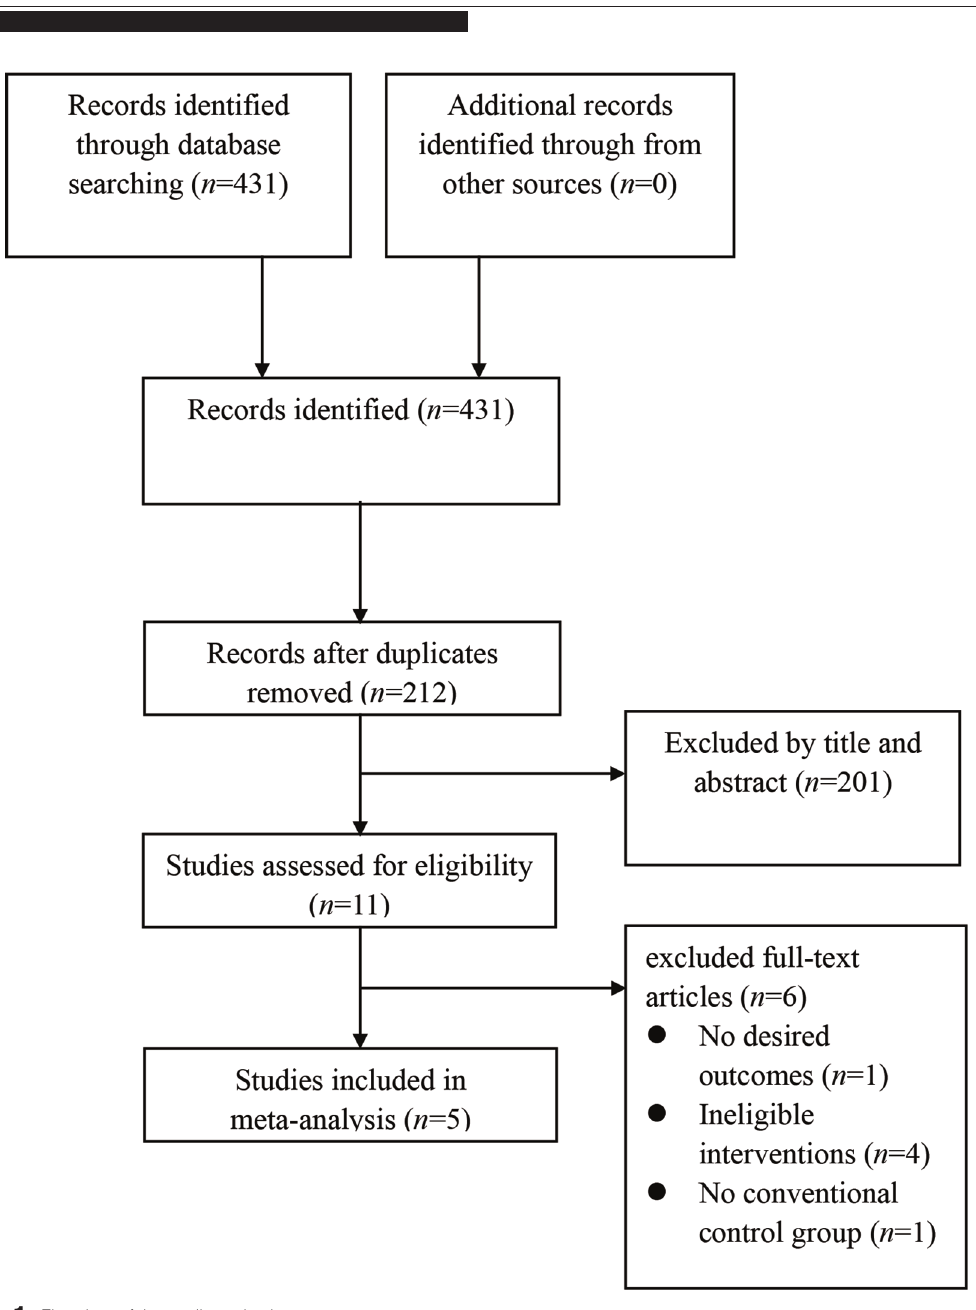
Figure 1. Flowchart of the studies selection